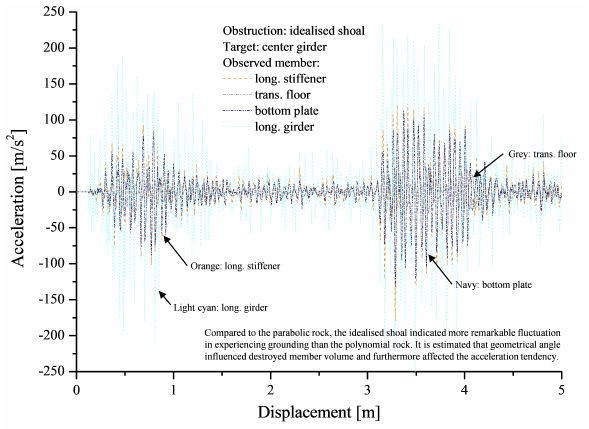
Figure 18: Damage-stress contours on the double bottom during impacted by the idealised shoal. The contours indicated the stress expansion was shrinking into smaller